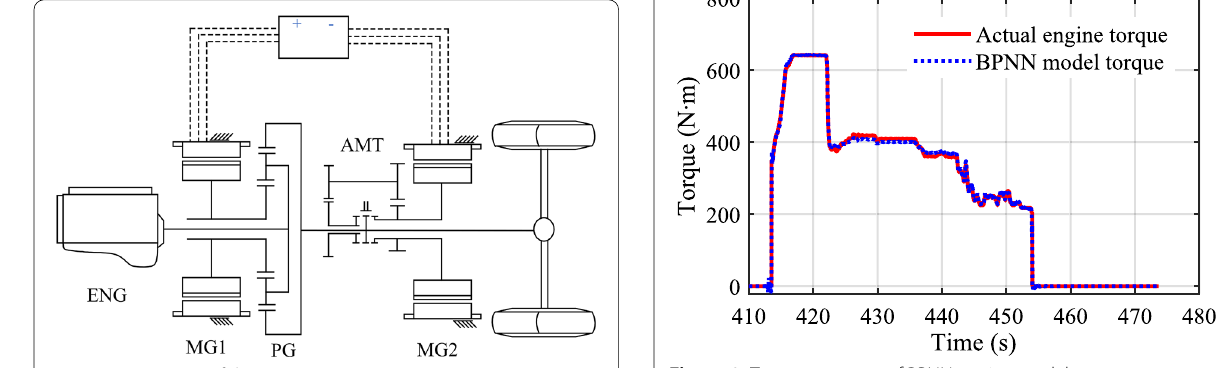
Figure 1 Structure of the PS-HEB powertrain Figure 2 Torque response of BPNN engine